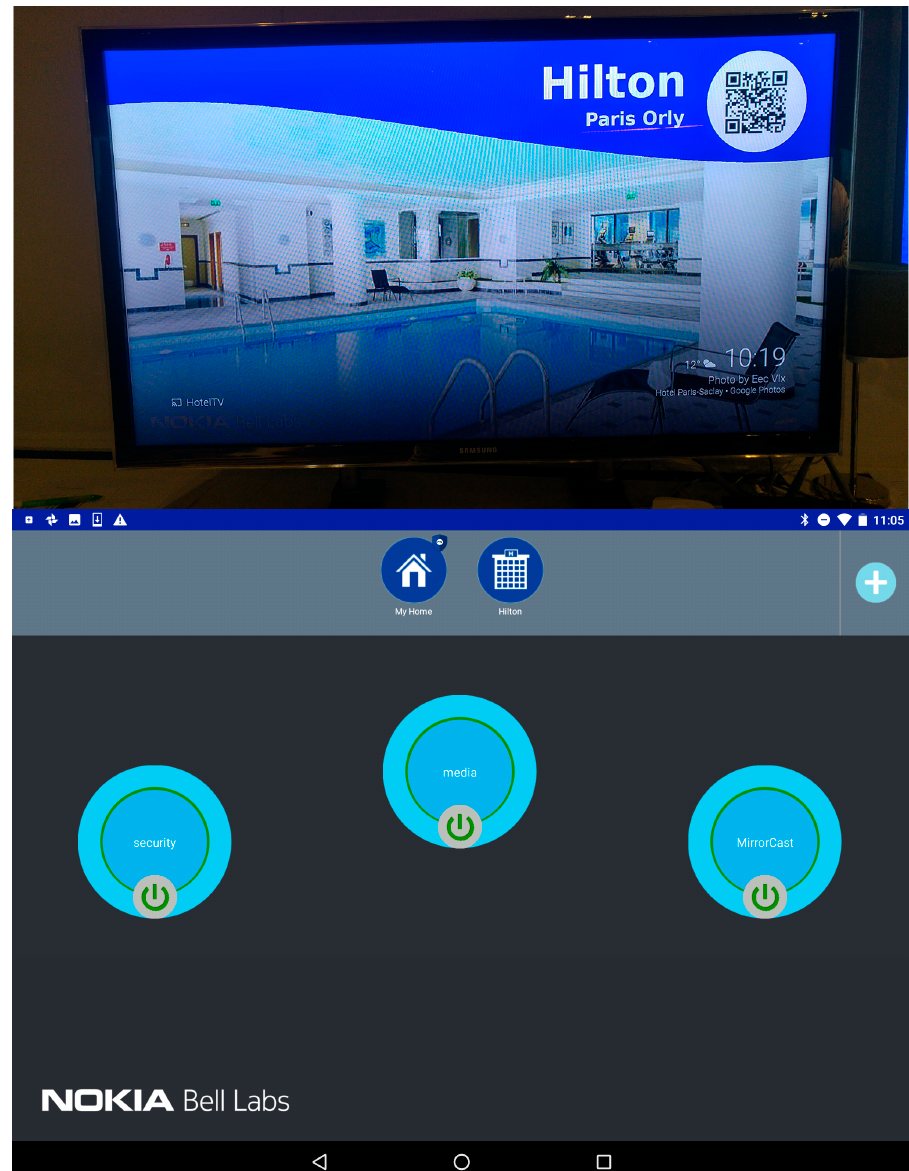
Figure 14. Scan of the QR code on the hotel TV to discover the hotel room vPlace.